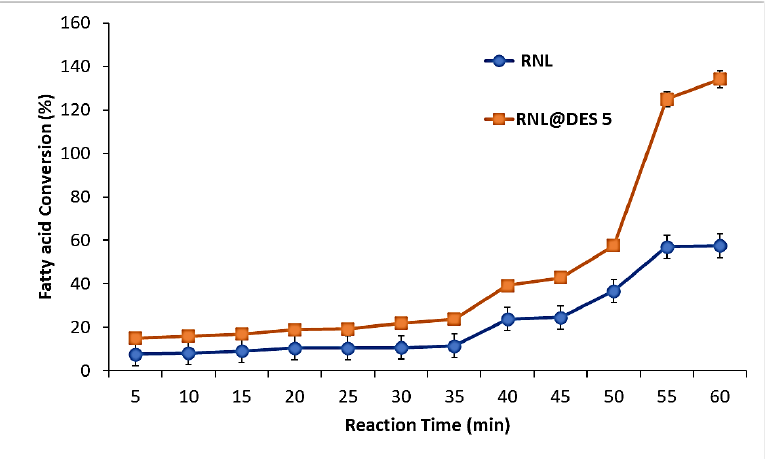
Figure 12. Fatty acid conversion (%) in free lipase with organic solvents compared to RNL@DES-5. Conditions of activated RNL@DES5 = pH 7.0, 40 °C for 2 h.